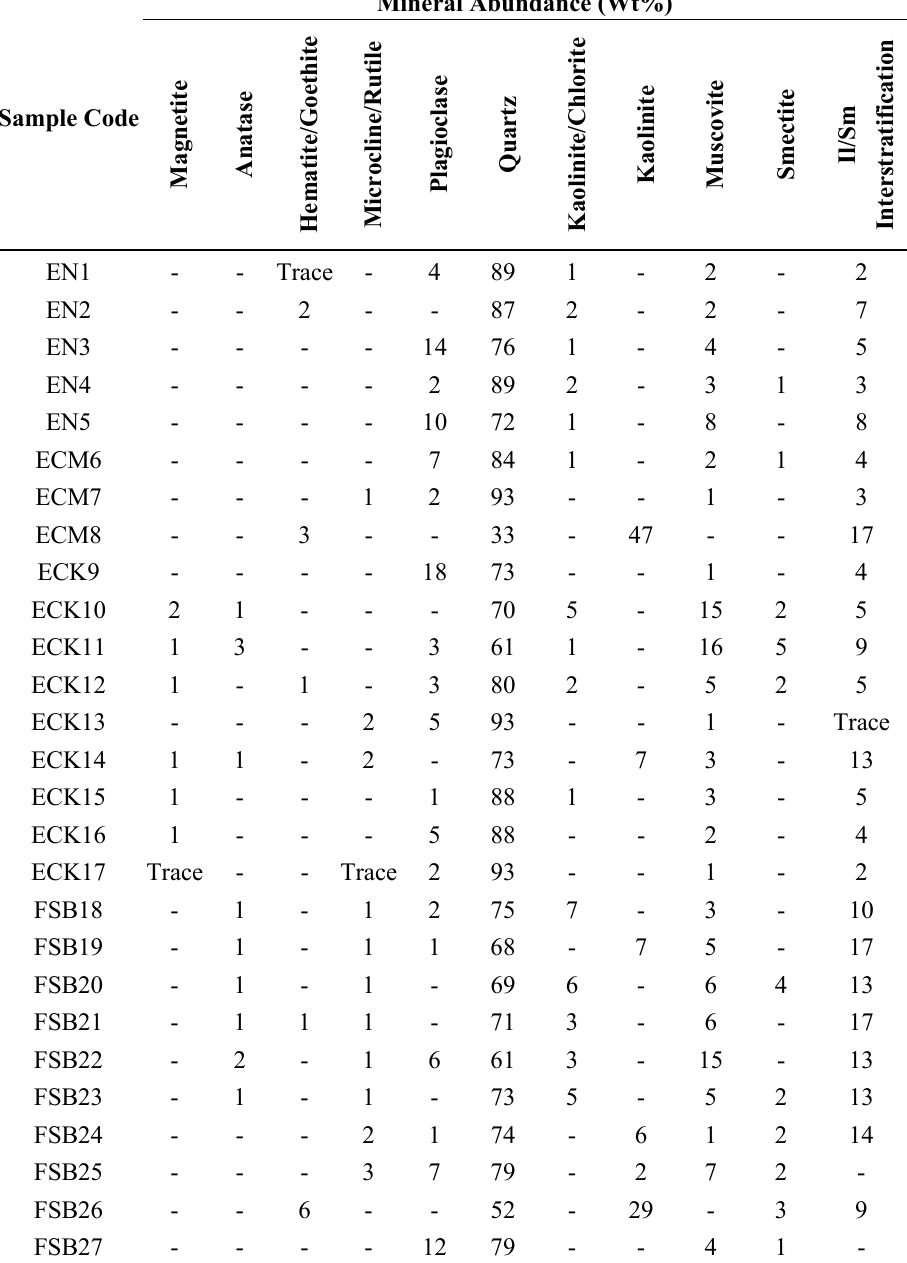
Table 3. Mineral assemblage of soil samples from South